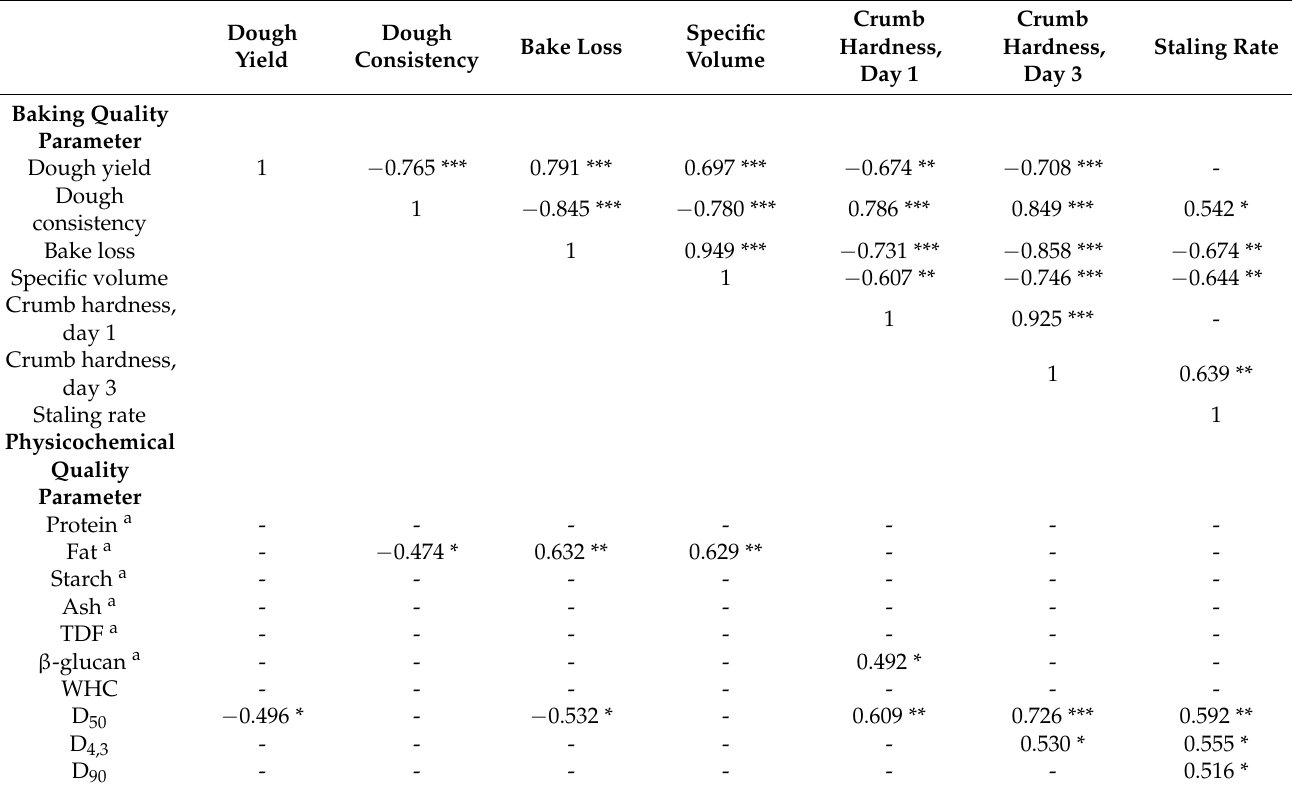
Table 3. Pearson’s correlation coefficients of the baking quality parameters with each other and with the physicochemical quality parameters of the oat cultivar samples ( n =